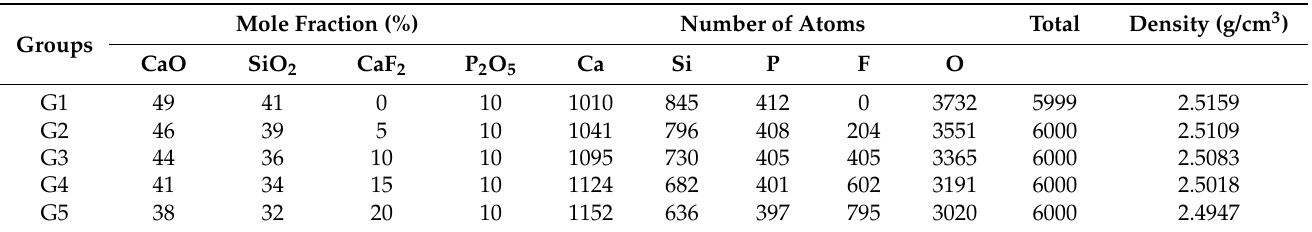
Table 2. Composition, number of atoms, and density of CaO-SiO 2 -CaF 2 -P 2 O 5 melts at 1600 ◦